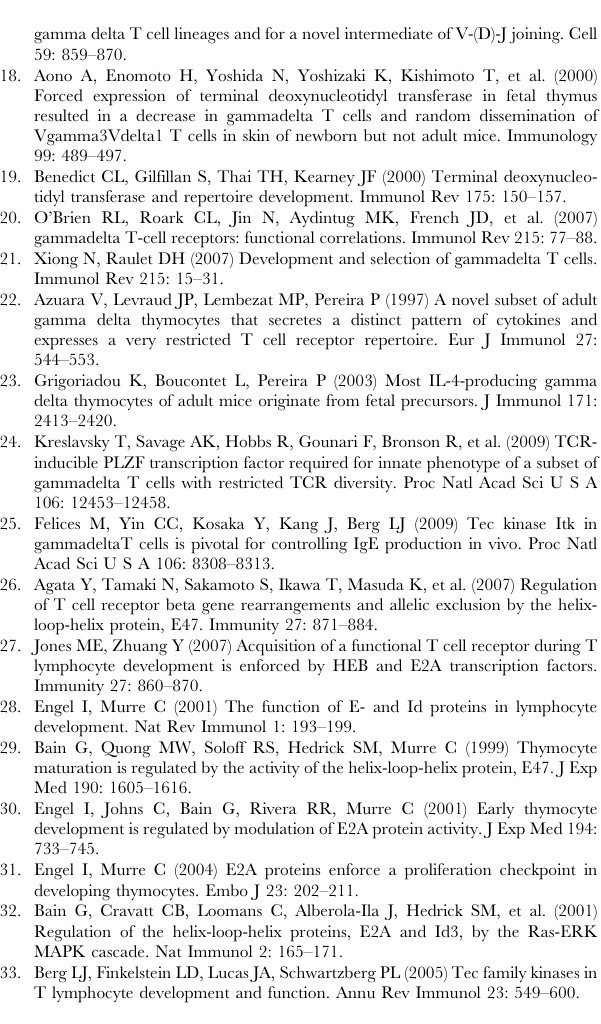
Figure S6 Id3 2 / 2 adult hematopoietic progenitors fail to reconstitute the cd T cell phenotype in Id3 + / + or Id3 2 / 2 mice. (A) Total bone marrow cells from Id3 + / + and Id3 2 / 2 (Ly5.2 + ) mice were injected into lethally irradiated (1000 rad) Id3 + / + and Id3 2 / 2 Ly5.1 + mice and thymocytes were analyzed 6 or 12 weeks post- reconstitution. Flow cytometric analysis for TCR b and TCR cd on total thymocytes is shown. Plots are representative of 2–3 independent experiments B) TCR b versus TCR cd profile for Id3 2 / 2 thymus for comparison. (C) Total numbers of cd T cells in Id3 + / + and Id3 2 / 2 mice without reconstitution (none) or after reconstitution in Id3 + / + or Id3 2 / 2 hosts. The average 6 standard deviation from 3 independent experiments is shown.